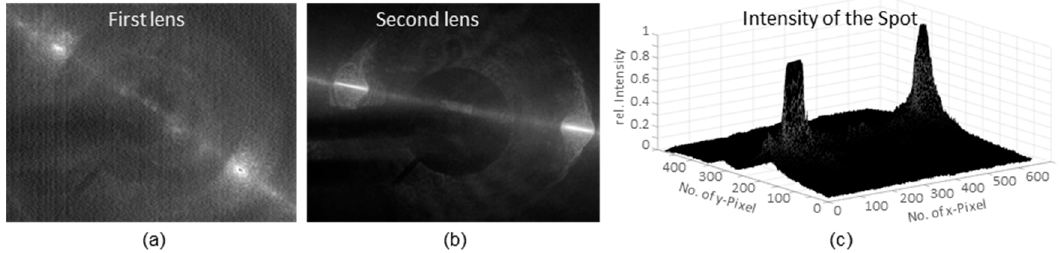
Figure 8. Spot shape measured with log-scale HDRC ® image